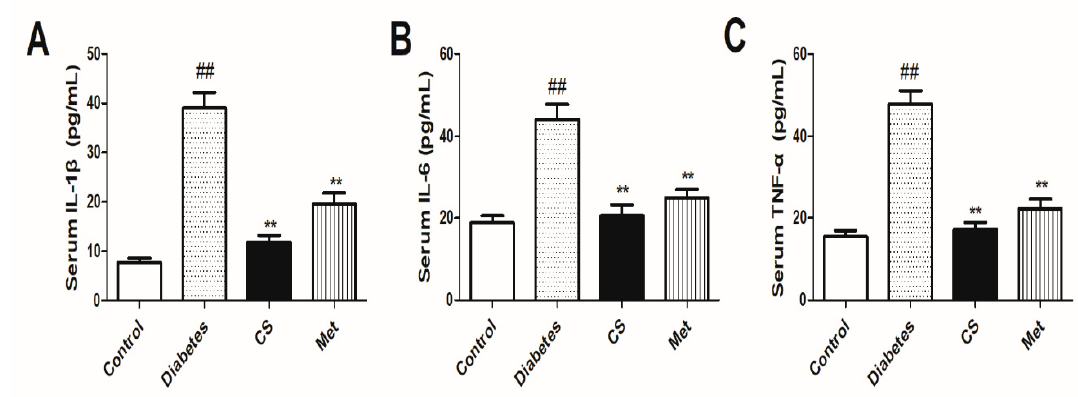
Figure 3. Serum levels of serum inflammatory cytokines (IL-1 β , IL-6) and tumor necrosis factor- α (TNF- α ) in each group at the end day of the animal experiment. ( A ) serum IL-1 β levels in each group; ( B ) serum IL-6 levels in each group; ( C ) serum TNF- α levels in each group. ## p < 0.01 compared with the control group; ** p < 0.01 compared with the diabetic group.